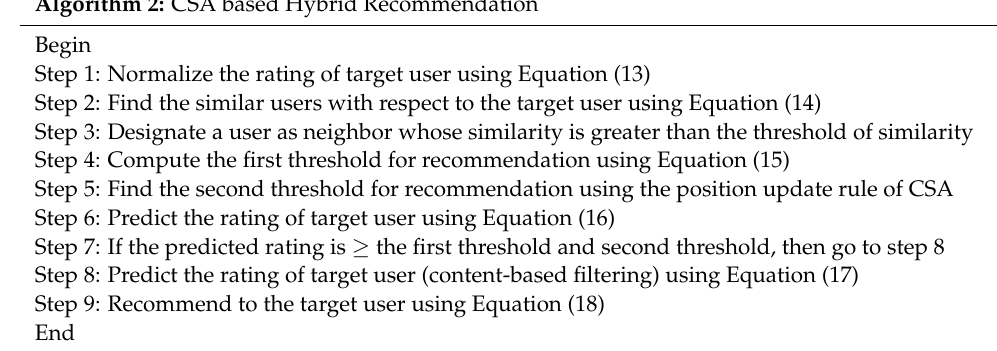
Algorithm 2: CSA based Hybrid